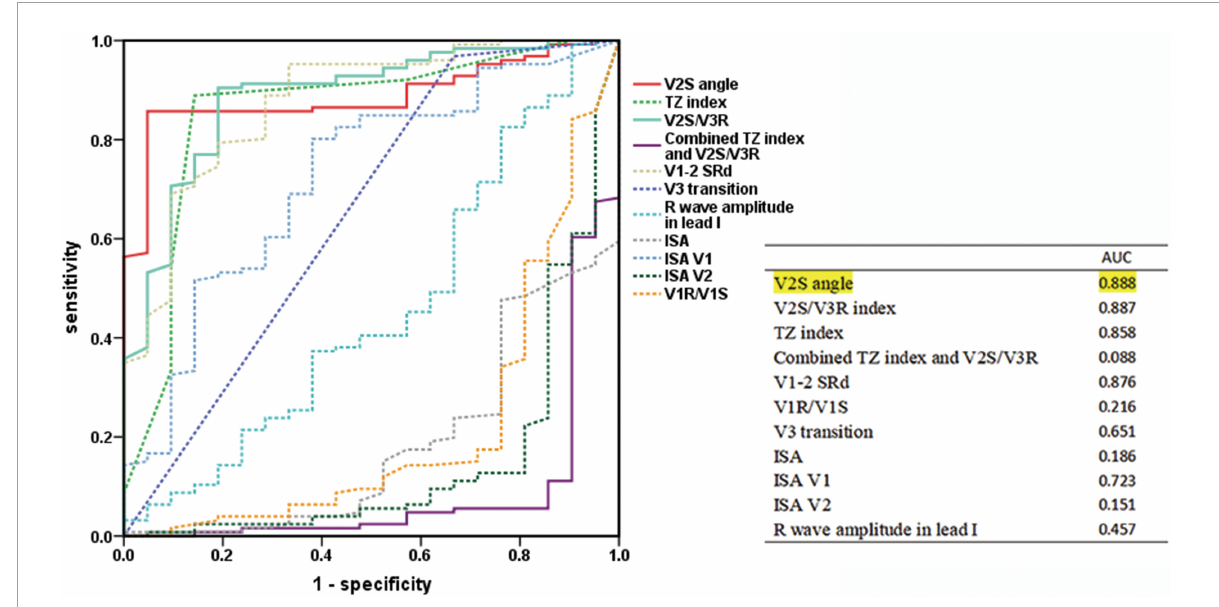
FIGURE3 Predictive accuracy of the V2S angle and several ECG algorithms of previous studies. ROC curve analysis for anatomic prediction of RVOT origin. The AUC of the V2S angle was 0.888, which was the highest of all.